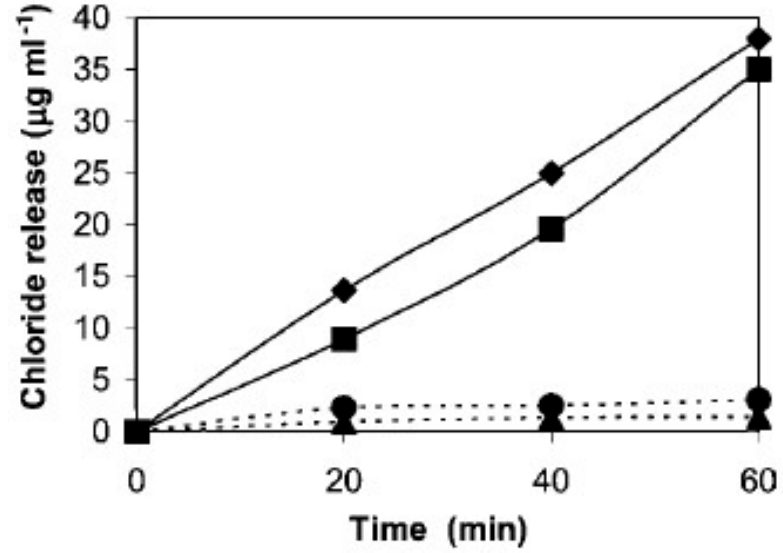
Figure 6. Dehalogenation of 5 mM (aq.) 2-chlorophenol. Solid lines: ( ◆ ) Chloride liberation catalyzed by Bio-Pd 0 and ( ■ ) by Chem-Pd 0 . Dashed lines: controls ( ▲ ), Desulfovibrio desulfuricans cells alone by Bio-Pd 0 and ( (cid:4) ) by Chem-Pd 0 . Dashed lines: controls ( (cid:78) ), Desulfovibrio desulfuricans cells alone (non-palladized resting cell biomass); ( ● ), finely divided Ref-Pd 0 ; data are means from two (non-palladized resting cell biomass); ( ), finely divided Ref-Pd 0 ; data are means from two experiments experiments (reprint from [92] with permission from Springer Nature. Copyright 2004). (reprint from [92] with permission from Springer Nature. Copyright